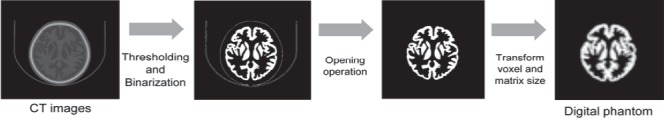
The flow chart of the development of the 3D digital brain phantom from CT images of the 3D brain phantom. All processes were performed using the ImageJ software program